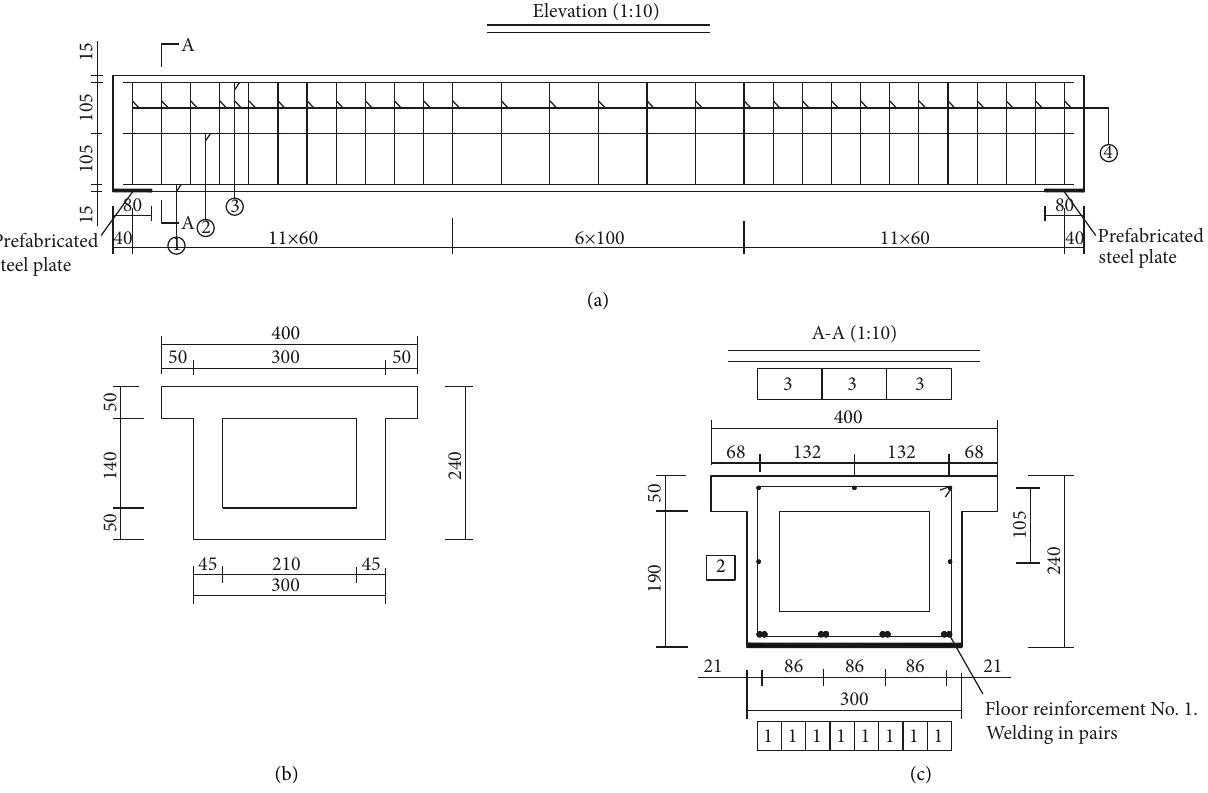
Figure 1: Section size and reinforcement arrangement of test beam (unit: mm). (a) Elevation. (b) Section. (c) Reinforcement